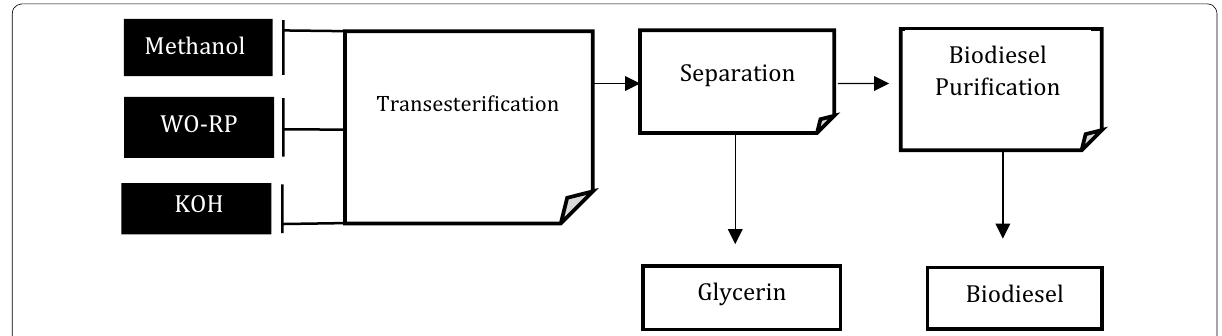
Fig. 1 Schematic flow of the transesterification